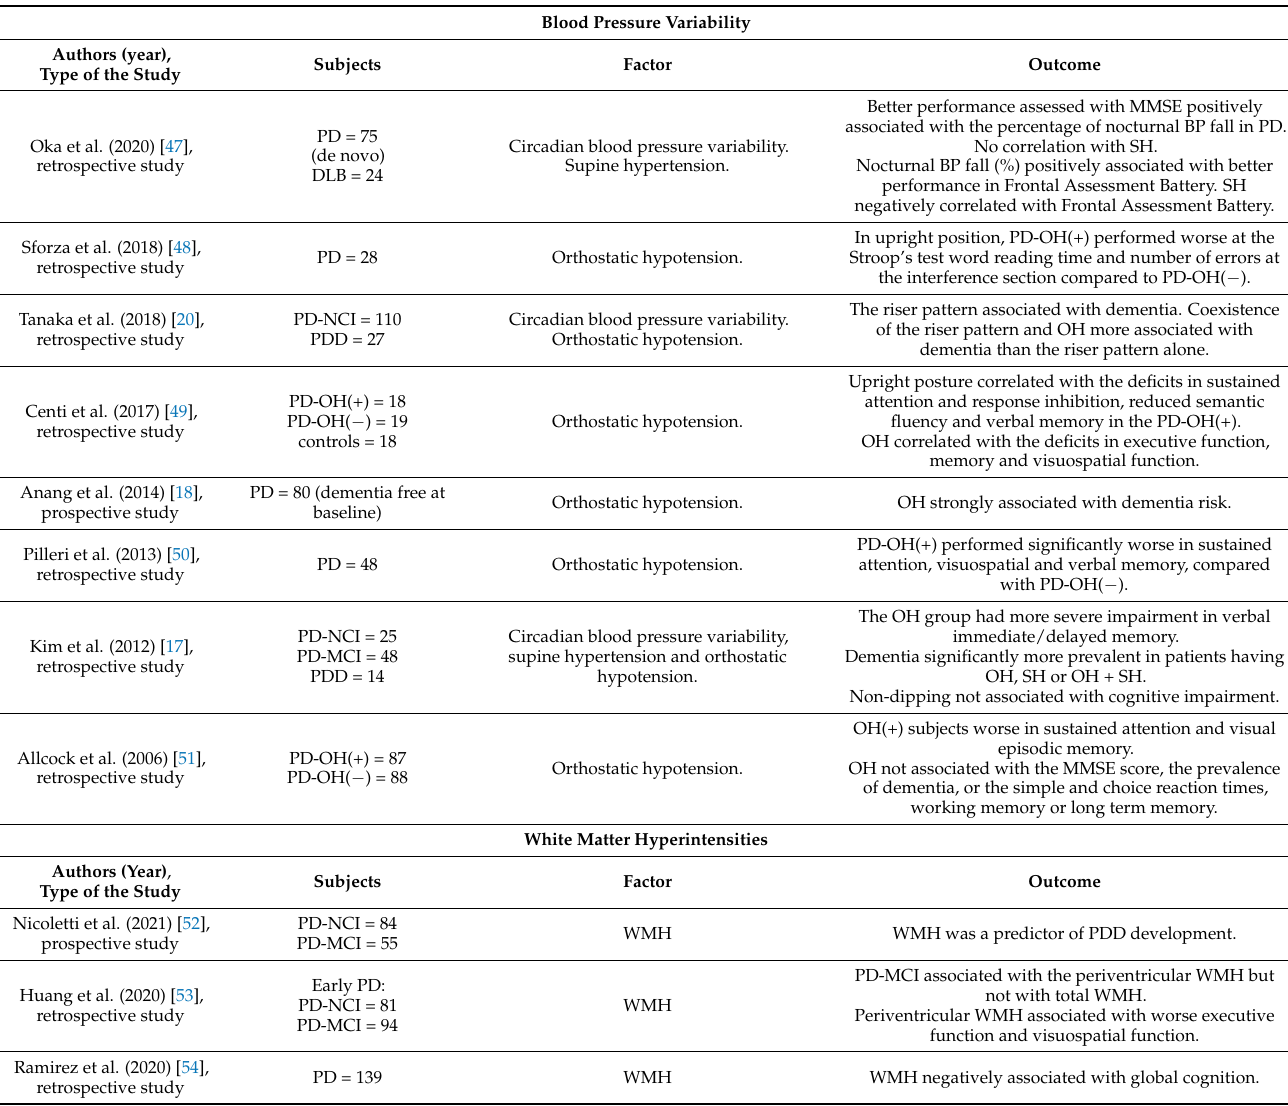
Table 1. Studies on the impact of blood pressure (BP) variability and white matter hyperintensities (WMH) on cognitive performance in Parkinson’s disease